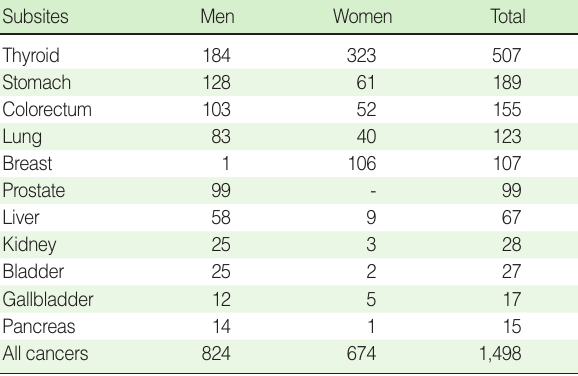
Table 3. The number of incident cancer cases